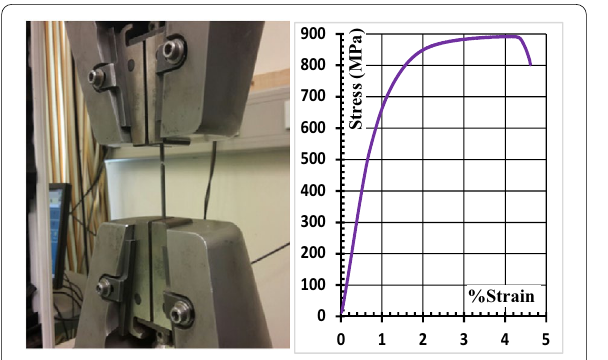
Fig. 3 Testing and stress–strain curve for WWM wires